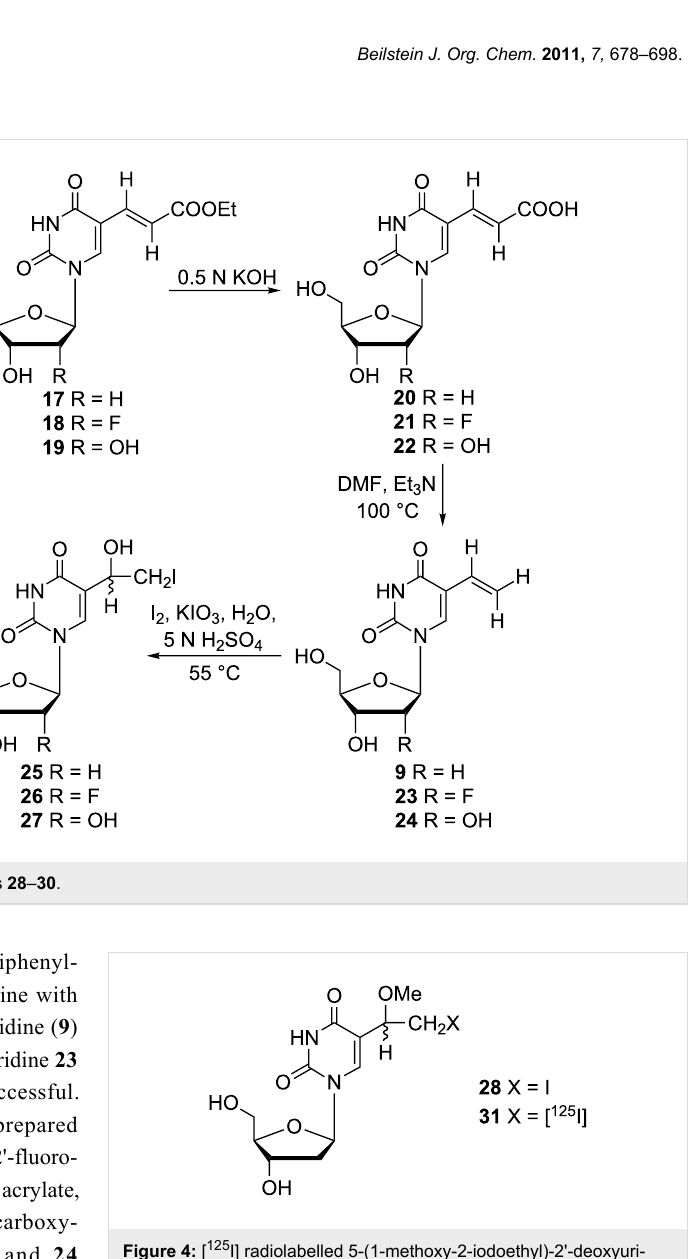
Figure 4: [ 125 I] radiolabelled 5-(1-methoxy-2-iodoethyl)-2'-deoxyuri- dine 31